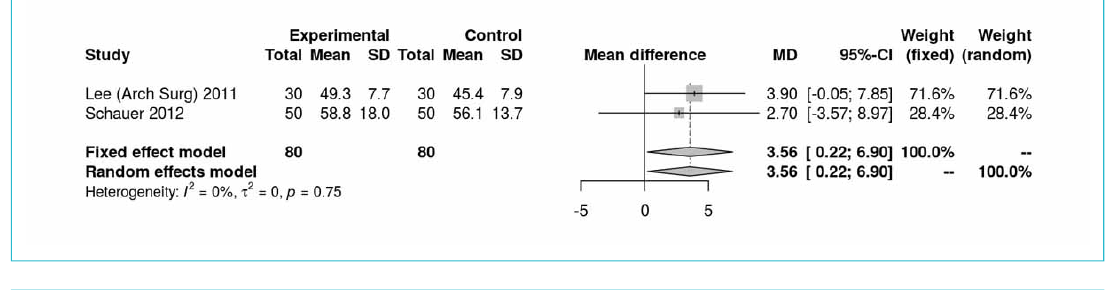
Figure S6n: High-density lipoprotein at 36 months (analysis of studies including only patients with type 2 diabetes).